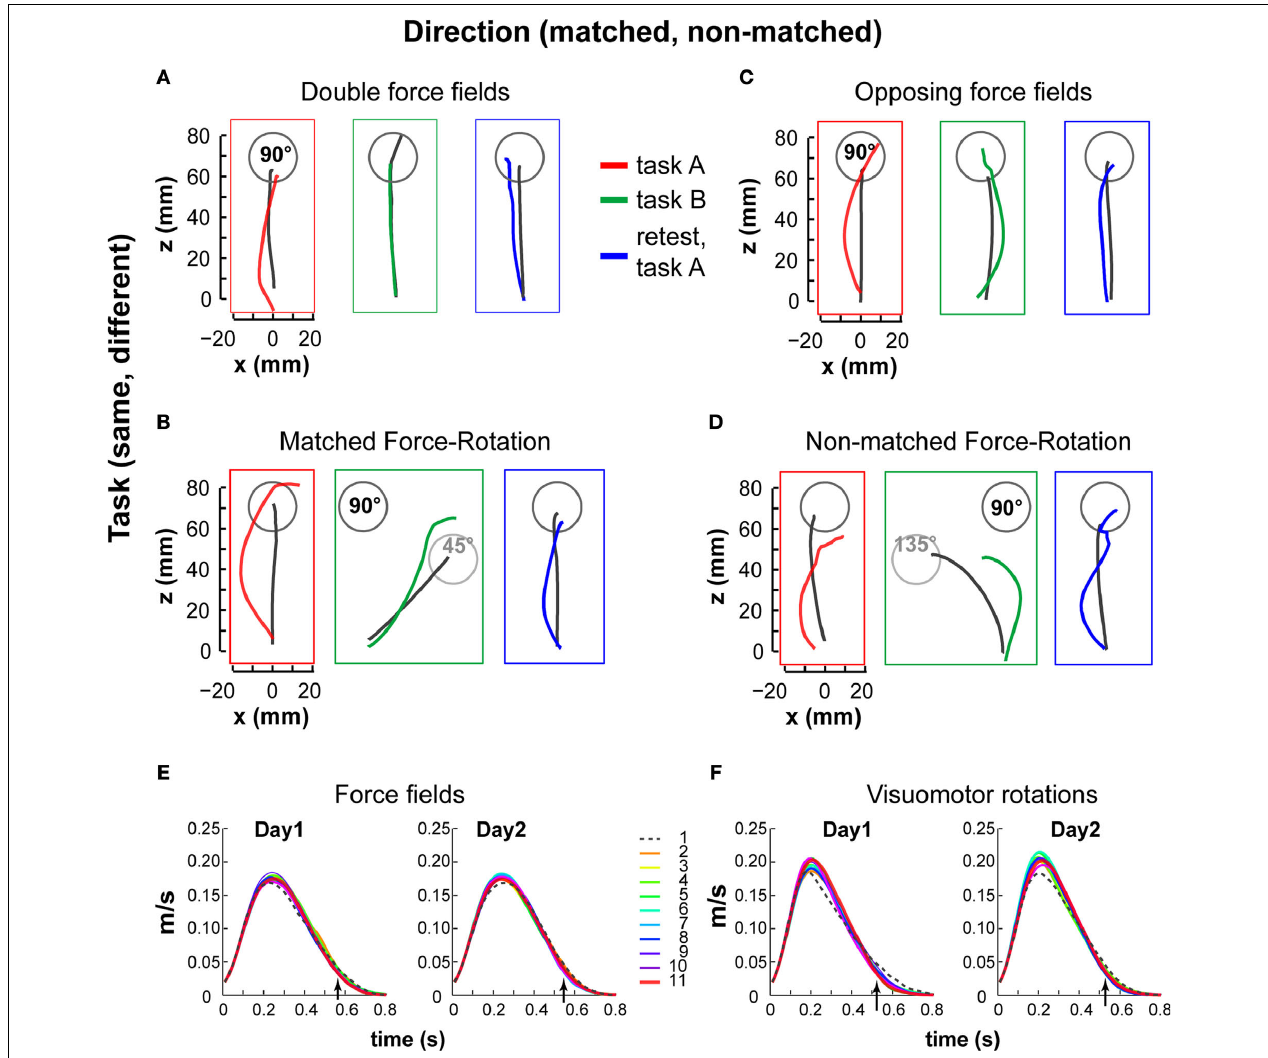
FIGURE 2 | Sequential adaptations to force fi elds and visuomotor rotations. Hand paths of representative subjects from each group following the A–B–A paradigm. The subplots are organized according to task (row) and direction of perturbations (column): double force fi eld (A) , matched force- rotation (B) , opposite force fi eld (C) , non-matched force-rotation (D) . Each subplot shows the average trajectories of early trials (trials 1–5, colored) and of late trials (trials 181–200, black) for tasks A and B performed on the fi rst day- session and for retest on task A 24 h later. Hand paths, plotted from detected movement onset to movement end, show displacement from origin to a target at 90 ° (gray circle). Learned target direction was always at 90 ° . In (B) ,